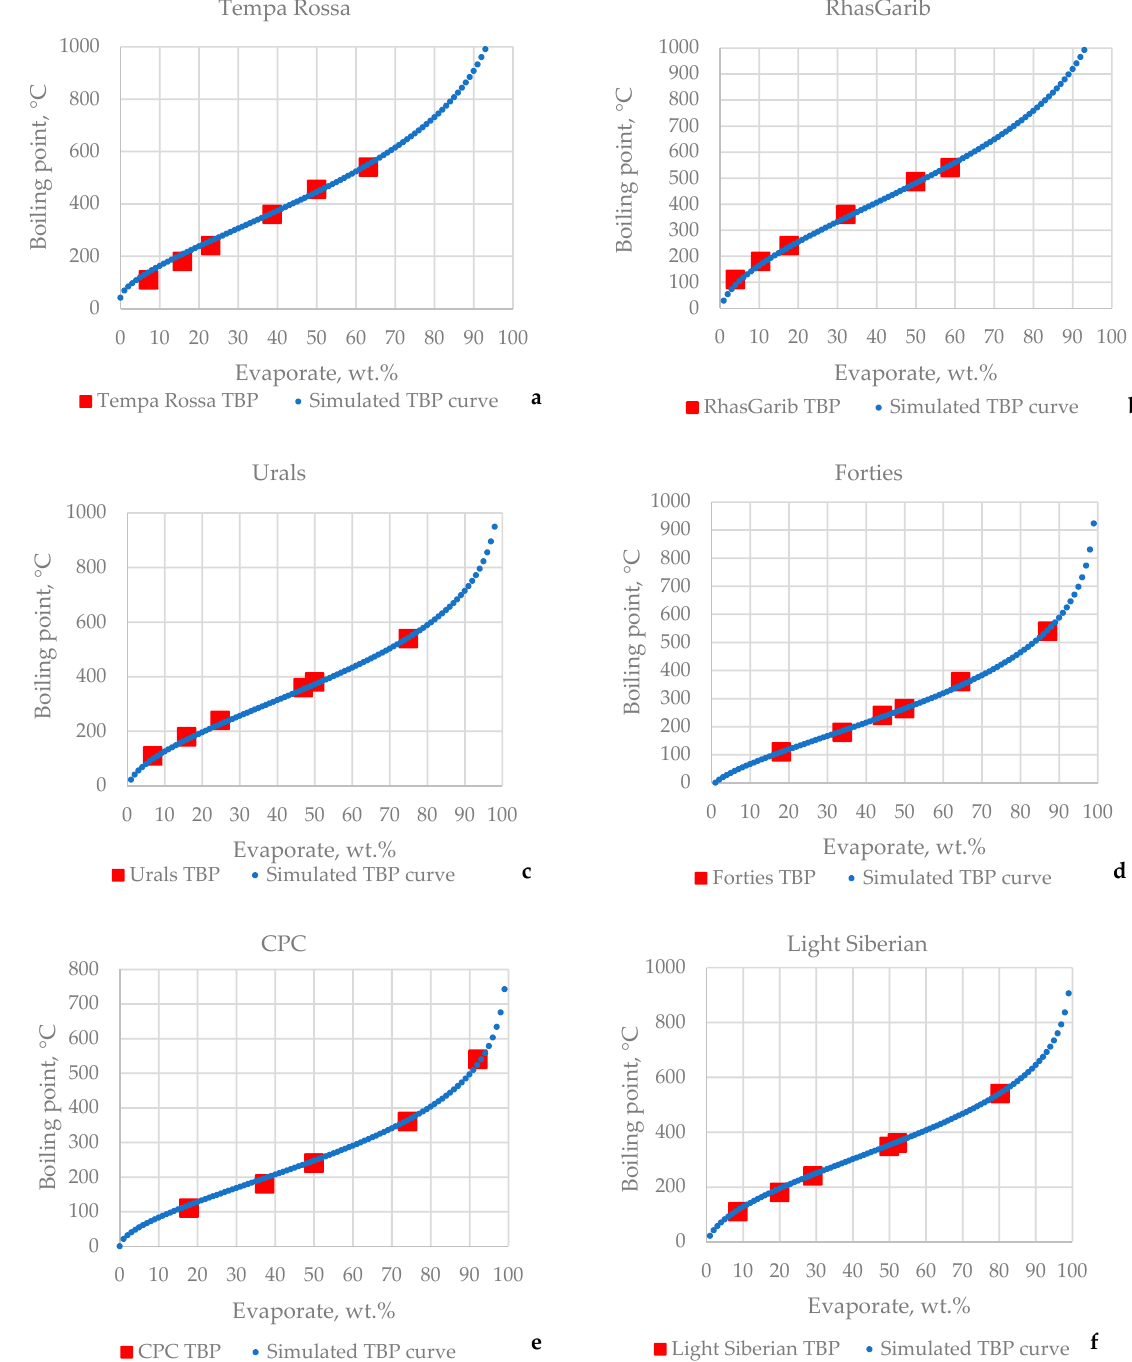
Figure 4. TBP curves of extra light ( d , e ), light ( f ), medium ( b , c ), and heavy ( a ) crude oils simulated with Equations (3)–(8) and Riazi’s distribution model (Equation (2)).